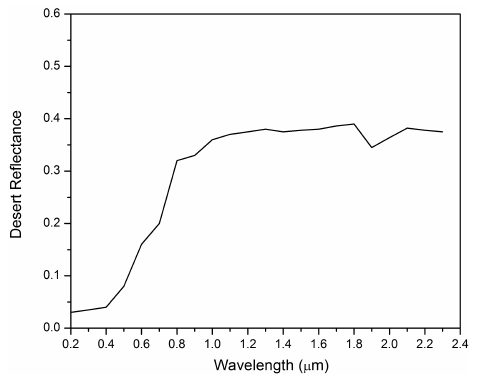
Figure 1. Empirical spectral reflectance of the desert from analysis of data in Aoki et al. (2002), Sadiq and Howari (2009), Bowker et al. (1985), and Koelemeijer et al. (2003), scaled by the PARASOL measurements.